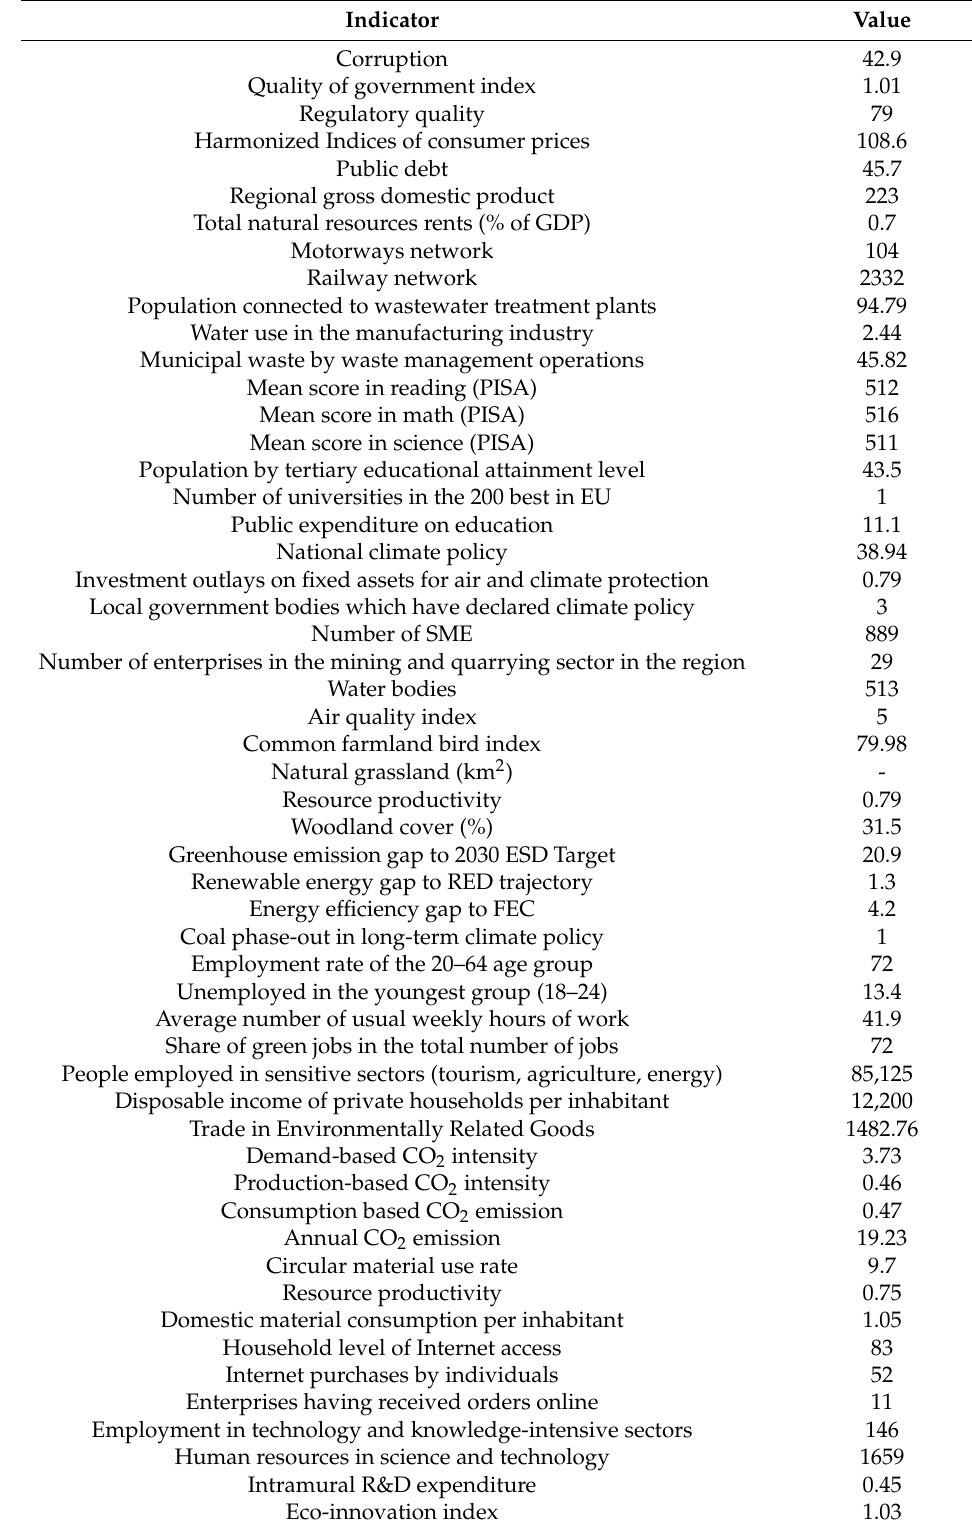
Table A1. Indicator values for the Mazowieckie